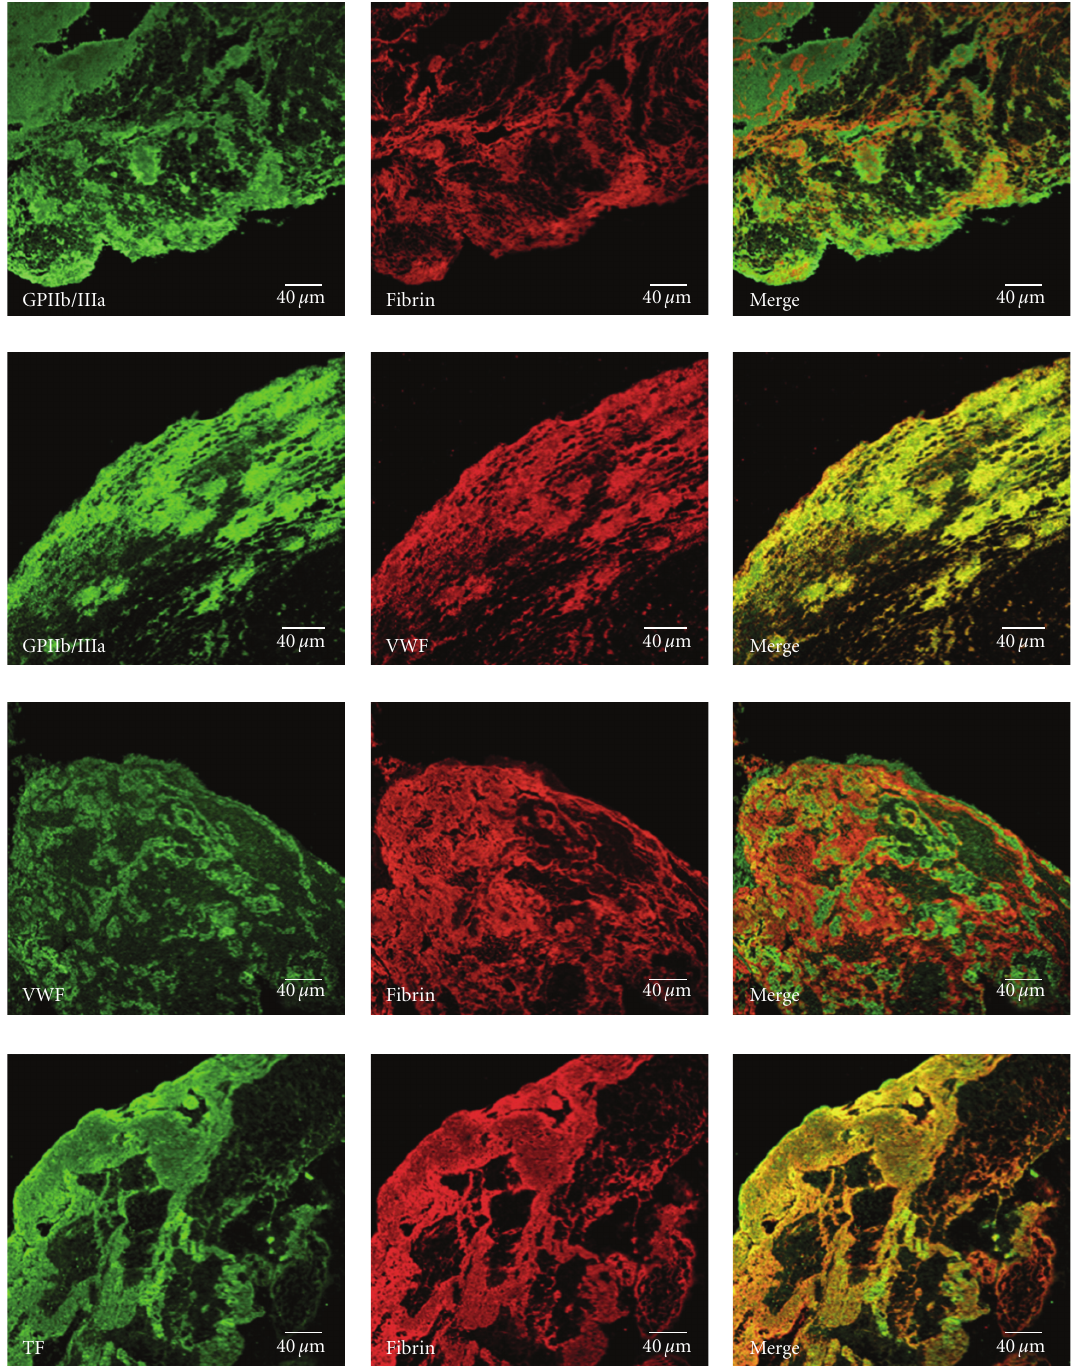
Figure 1: Immunofluorescence images of fresh coronary thrombi from patients with acute myocardial infarction. Images of thrombi stained with fluorescein isothiocyanate-labeled glycoprotein (GP) IIb/IIIa, von Willebrand factor (VWF), or tissue factor (TF) (green), Cy3-labeled fibrin or VWF (red), and merged images. Areas with colocalized factors are stained yellow (from Yamashita et al. [5] with